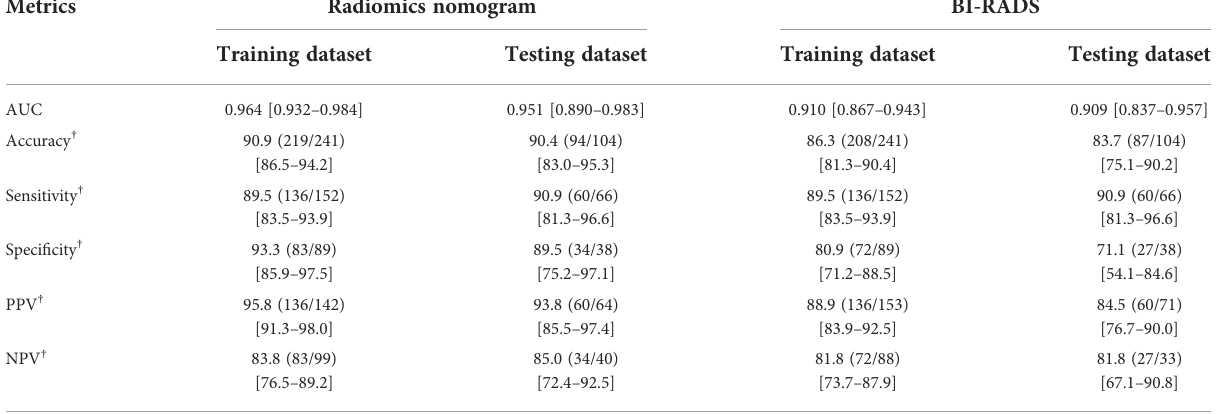
TABLE 5 The diagnostic performance of radiomics nomogram and BI-RADS classi fi